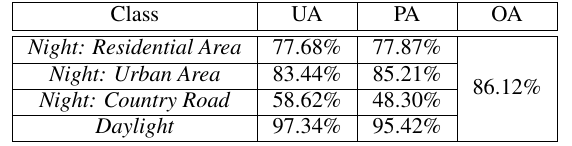
Figure 8: Image cutouts used to train the pedestrian detector: a) positive cutout showing a pedestrian, b) negative cutout showing no pedestrians.